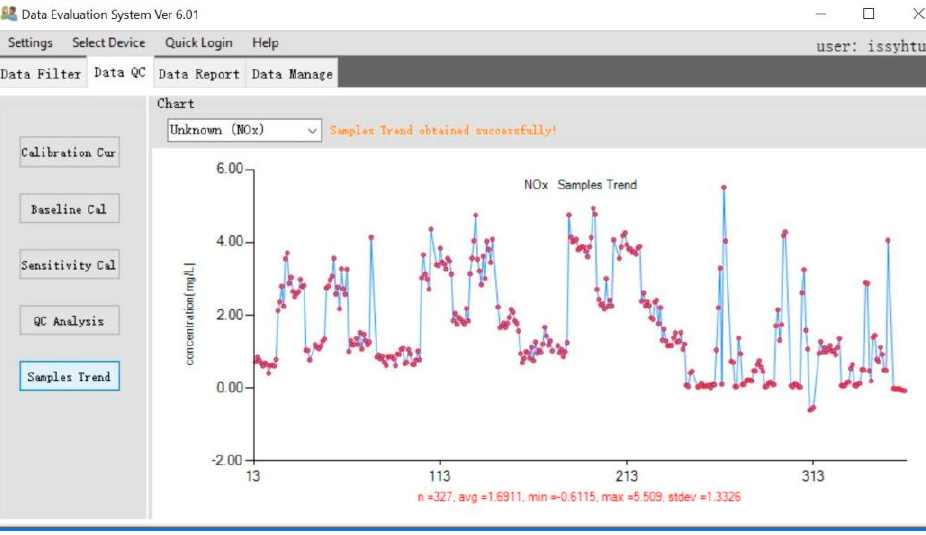
Figure 14. Sample data trend of the detection.